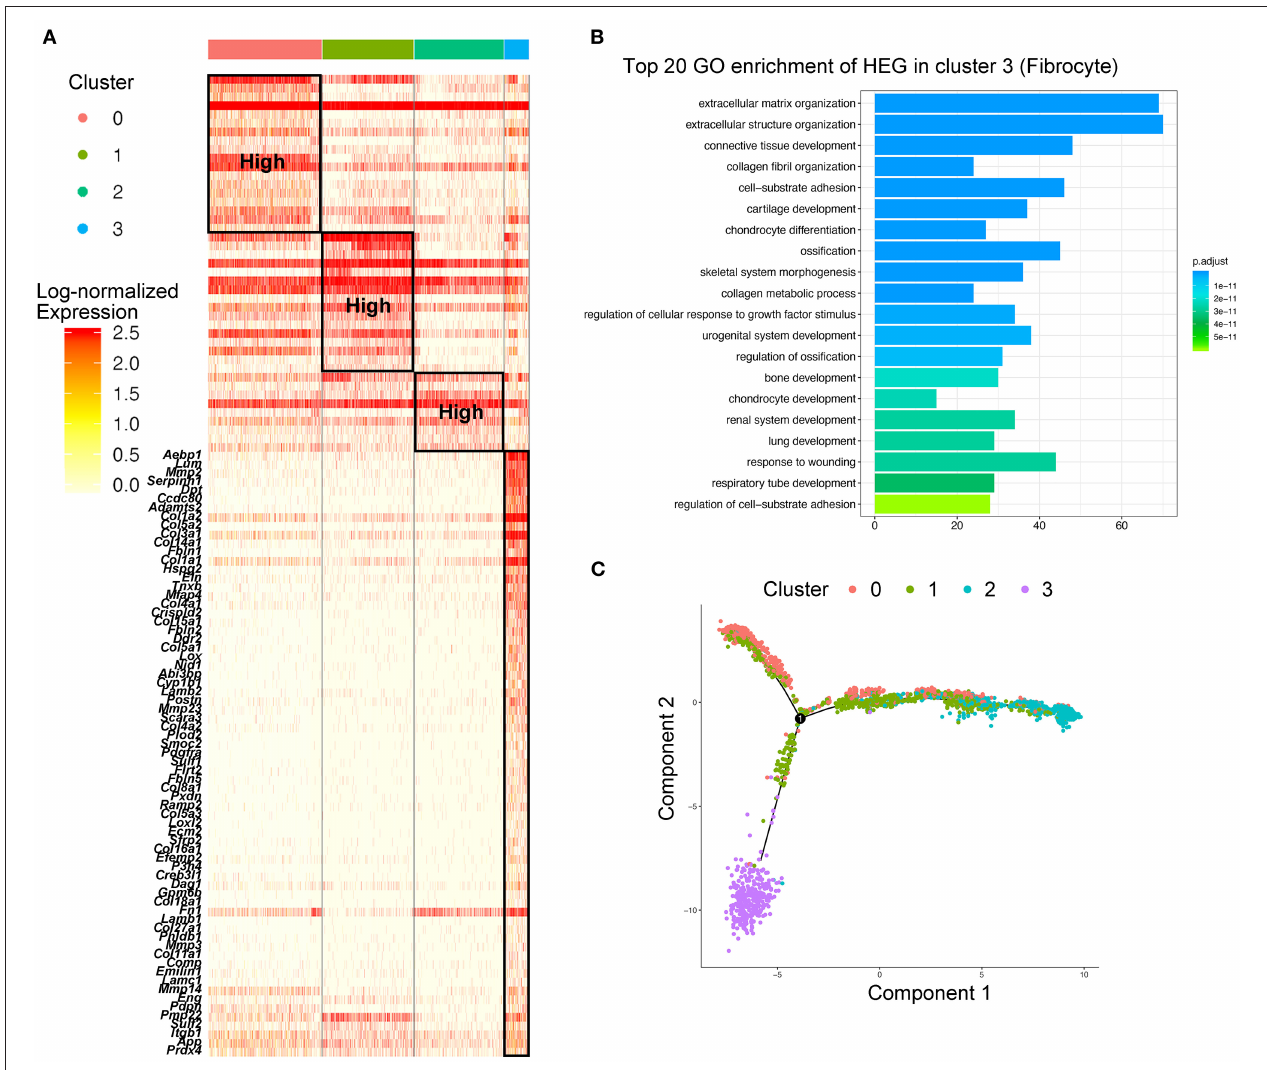
FIGURE 3 | Identification of fibrocytes that were distinct from macrophages in AAA. (A) Heatmap of highly expressed genes (HEGs) from three subtypes of macrophages and fibrocytes (Cluster 3), The HEGs of fibrocytes compared with macrophage subtypes were labeled (lower part), and the HEGs of macrophage subtypes (upper part) were the same as Figure 2B . (B) Bar plot of Gene Ontology (GO) pathway enrichment of the HEGs in fibrocytes. (C) Pseudo-time plot by trajectory analysis of three clusters of macrophages (Cluster 0: Trem2 + Acp5 + macrophages; Cluster 1: Mrc1 + Cbr2 + M2-like macrophages; Cluster 2: Il1b + Ccr2 + M1-like macrophages; Cluster 3: Cd34 + Col1a2 +